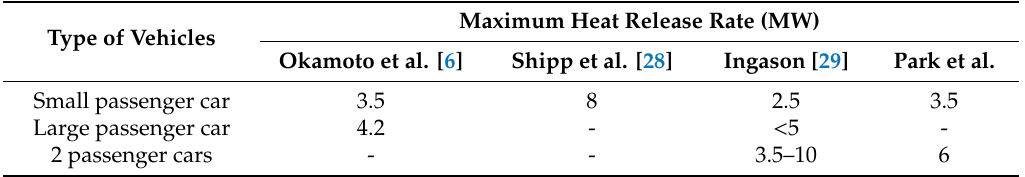
Table 4. Comparison of maximum heat release rates throughout large-scale experiments.